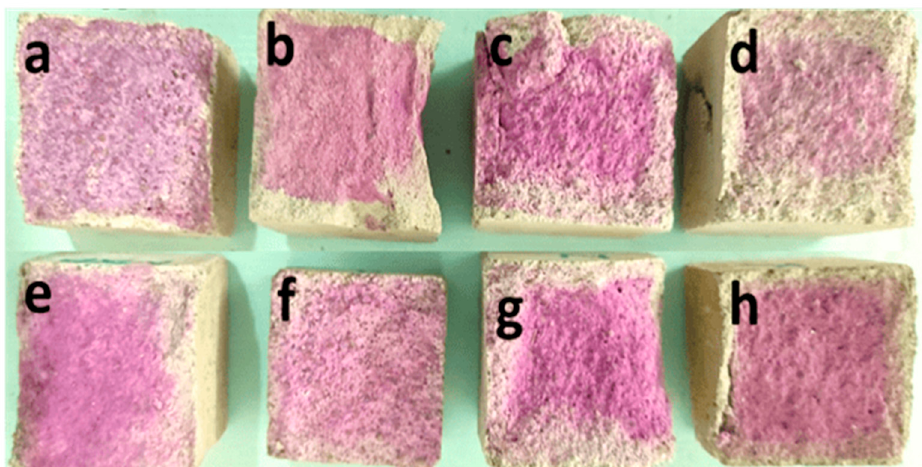
Figure 2. Carbonation tests on organic lime mortar samples: ( a ) kadukkai lime mortar; ( b ) cactus lime mortar; ( c ) aloe vera lime mortar; ( d ) hibiscus lime mortar; ( e ) jaggery lime mortar; ( f ) neelamari lime mortar; ( g ) K + J lime mortar; and ( h ) mixed lime mortar.